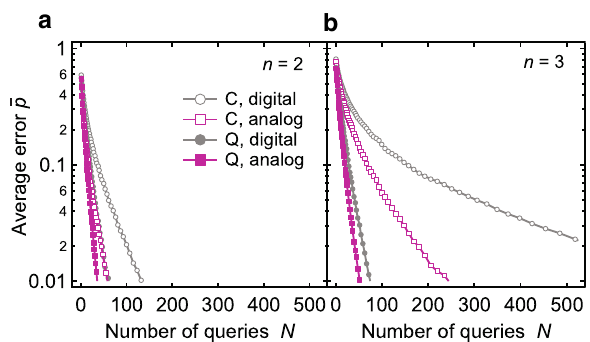
Fig. 3 Learning error probability p averaged over all the n -bit oracles k , for different n and solvers. a n = 2, b n = 3. Making use of ; ¼ V ; V the analog measurements f V D D n A g ( squares ) improves over 1 the digital solvers in Fig. 2 ( circles ) for both classical ( empty symbols ) and quantum ( solid symbols ) learning. The analog solver in Q proves to be the most ef fi cient solution. Moreover, the gap between Q and C grows with n . The same dataset is used in Figs 2 and 3, with D 3 ignored in the analysis for n = 2. See Supplementary Information for the p ( N ) corresponding to each 3-bit k